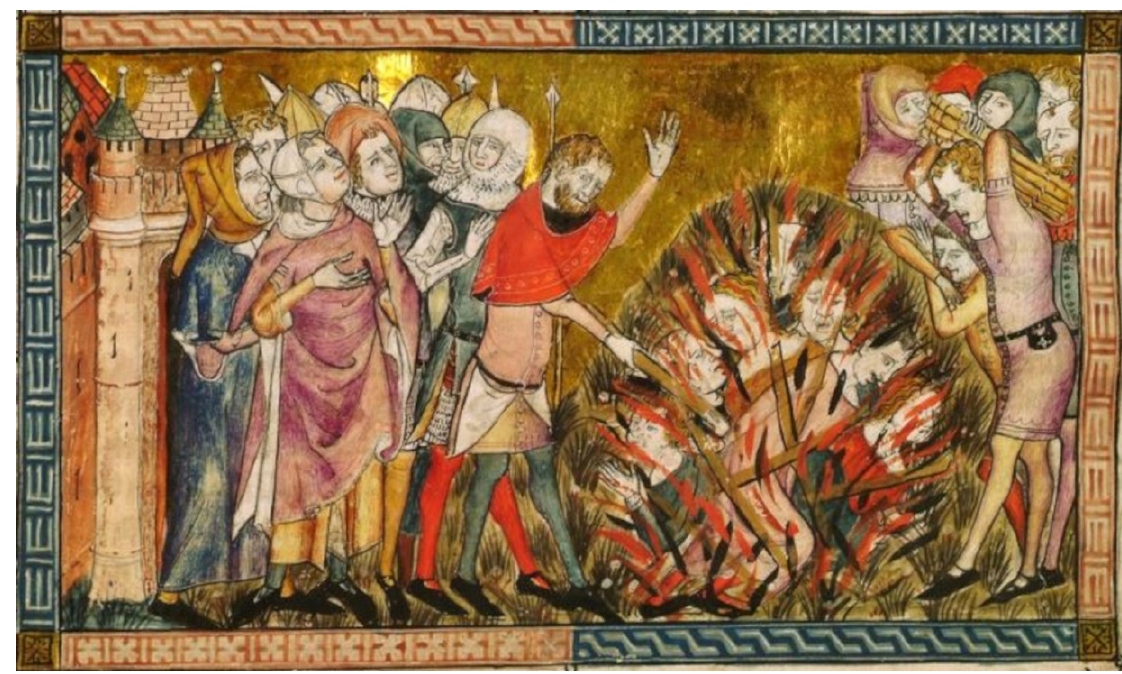
Figure 3. Jews being burned at the stake in 1349. Miniature from a 14th century manuscript Aniquitates Flandriae created by Pierart dou Tielt (Belgian miniaturiste, 1340–1360). Source: By Pierart dou Tielt (fl. 1340–1360)-http://ba-